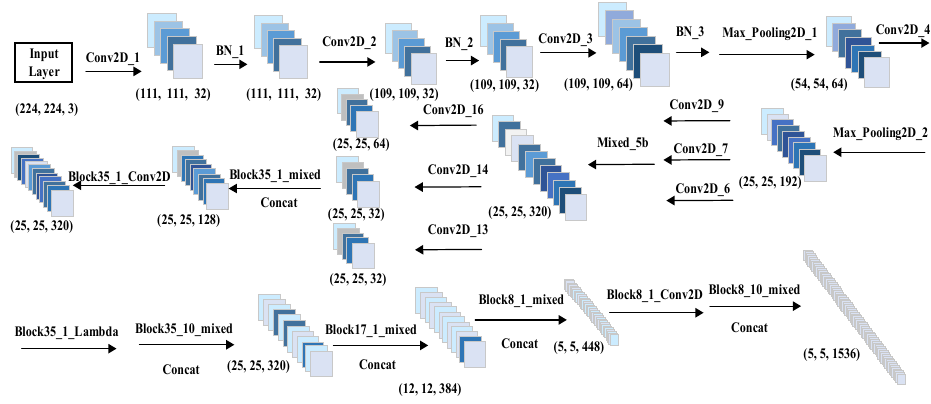
Figure 2. InceptionResNetV2-TA network architecture.